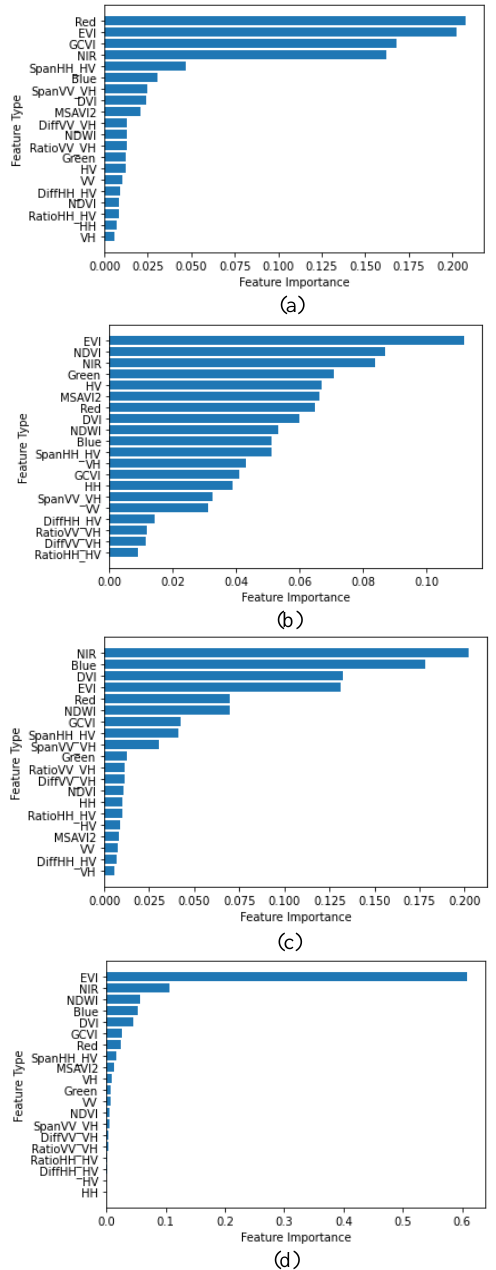
Figure 1 . Variable importance measuring: (a) DT, (b)